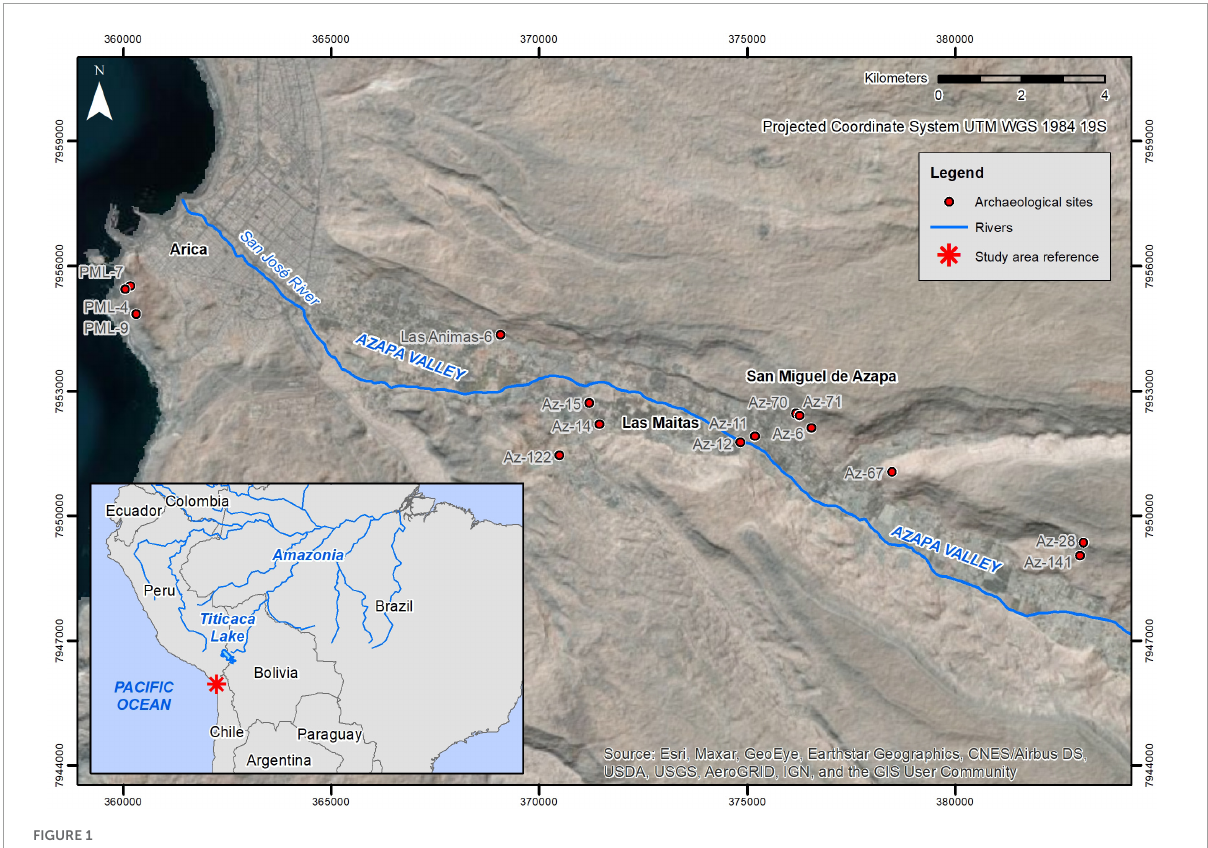
FIGURE1 Study area including sites with macrobotanical remains analyzed in this study.